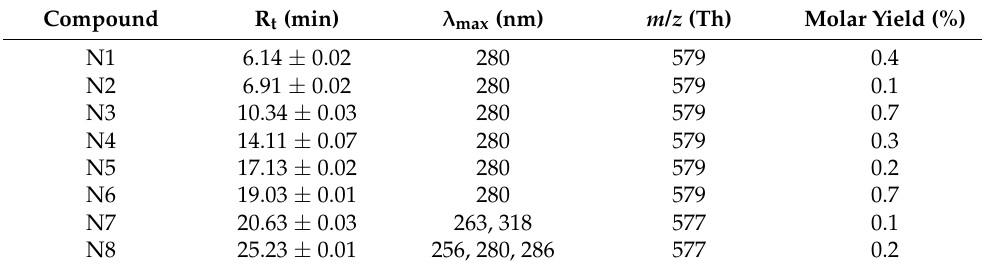
Table 1. Analytical reversed-phase UHPLC retention times, absorbance maxima, corresponding m/z (Th), and yields (%) for the eight major oxidation products